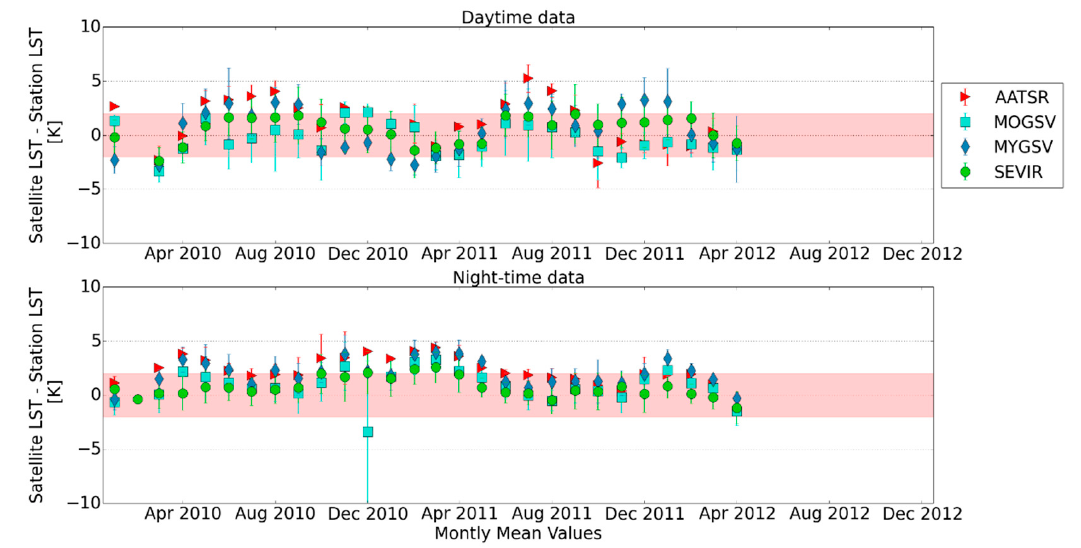
Figure 13. Monthly median accuracies (satellite LST–station LST) over EVO station for the years 2010–2012. The upper plot shows daytime and the lower night-time data. The ranges shaded in red indicate the ±2.0 K accuracy range.